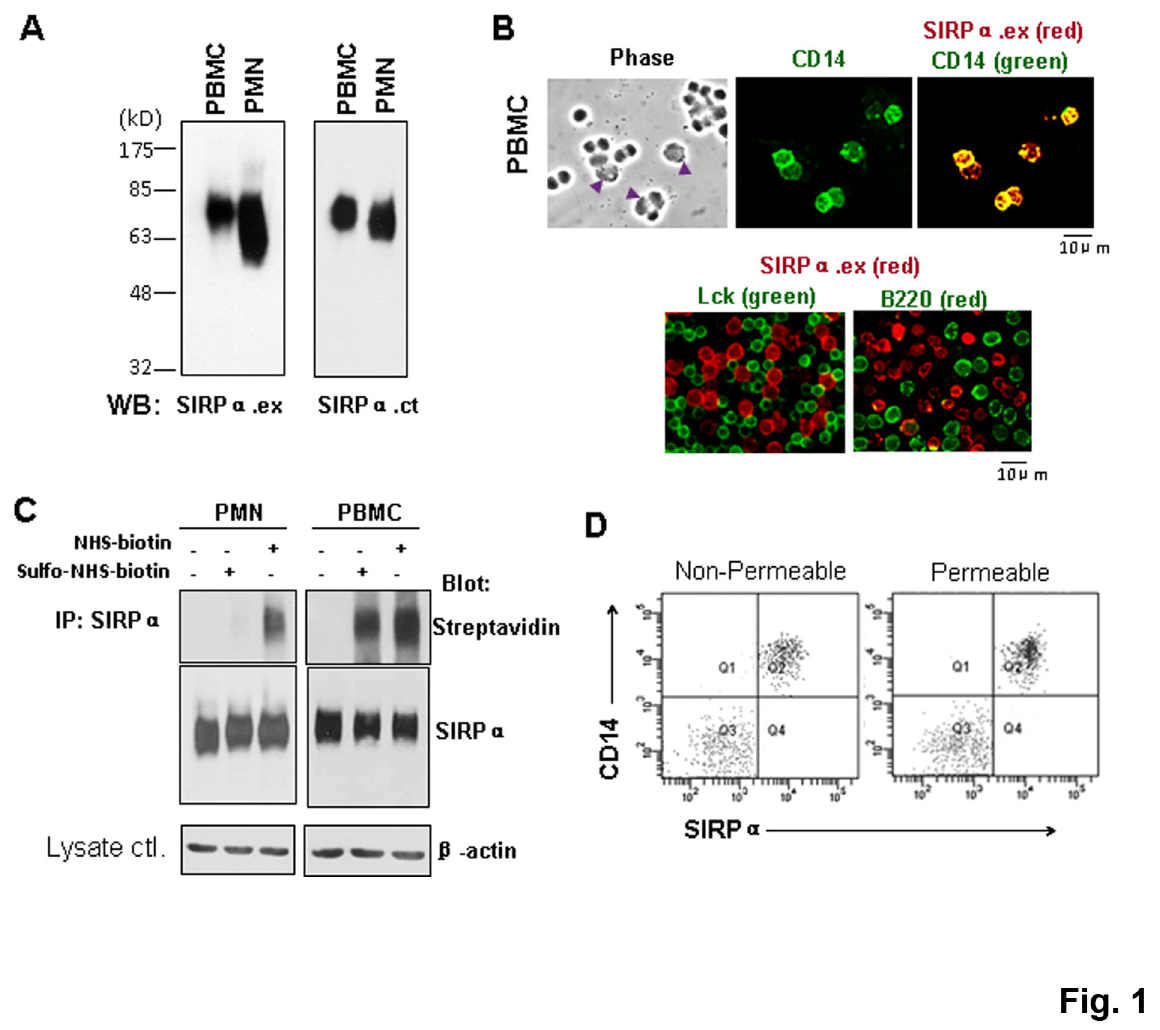
Figure 1. Expression of SIRPα on monocytes. Detection of SIRPα by WB in freshly isolated human PBMC and PMN using anti- SIRPα.ex (SIRPα.ex) and anti-SIRPα.ct (SIRPα.ct) antibodies. B) Immunofluorescence staining of PBMC. Cell surface SIRPα was labeled with anti-SIRPα.ex under non-permeable conditions. Monocytes (arrow heads) were defined by anti-human CD14 antibody, and T and B lymphocytes were defined with anti-Lck and anti-B220 antibodies, respectively. C) Determination of the distribution of SIRPα in PMN and monocytes by cell biotinylation. Cells were biotinylated with either NHS-biotin (cell permeable) or sulfo-NHS- biotin (non-cell permeable), followed by the IP of SIRPα from the lysates. Biotinylated and total SIRPα were blotted by streptavidin- HRP and anti-SIRPα.ct, respectively. The same amount of protein was used for IP as confirmed by the actin blots. D) FACS analysis to determine SIRPα in monocytes labeled under cell permeable and non-permeable